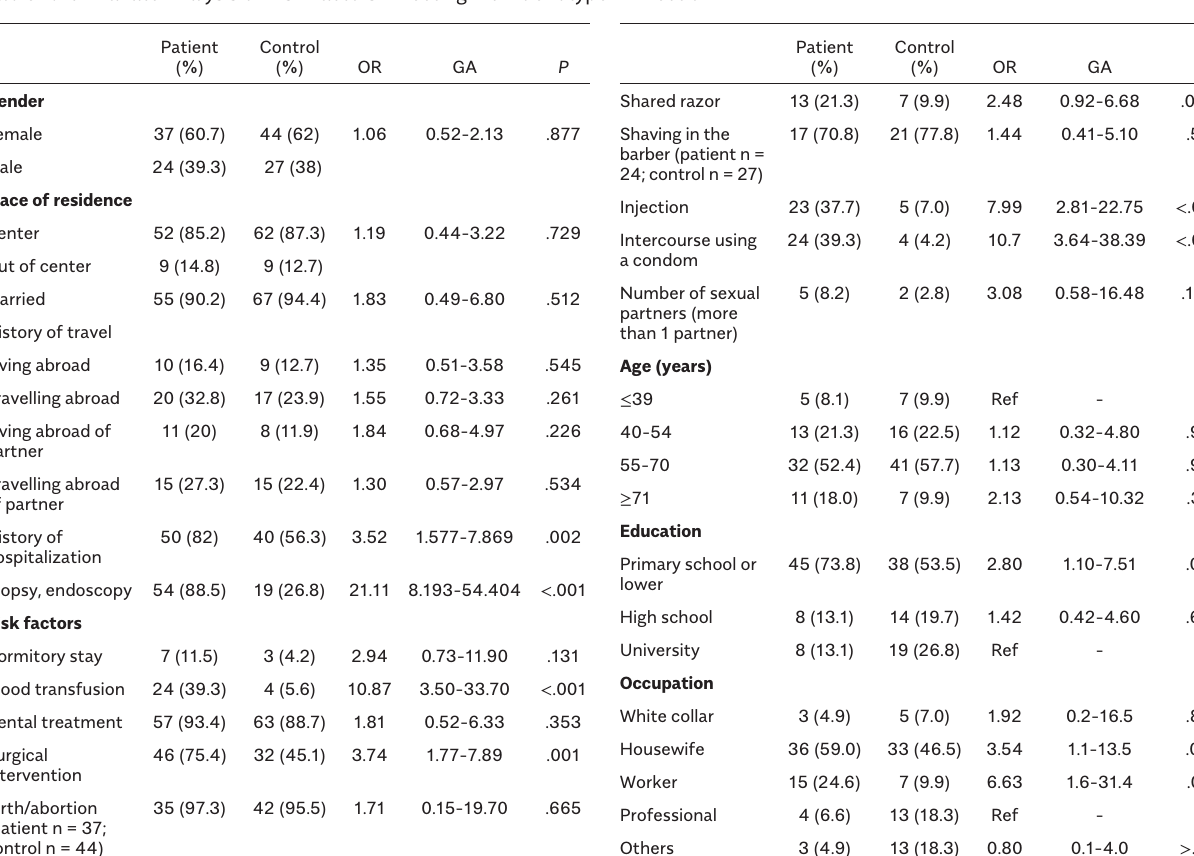
Table 1. Univariate Analysis of Risk Factors Affecting HCV Genotype 4 Infection